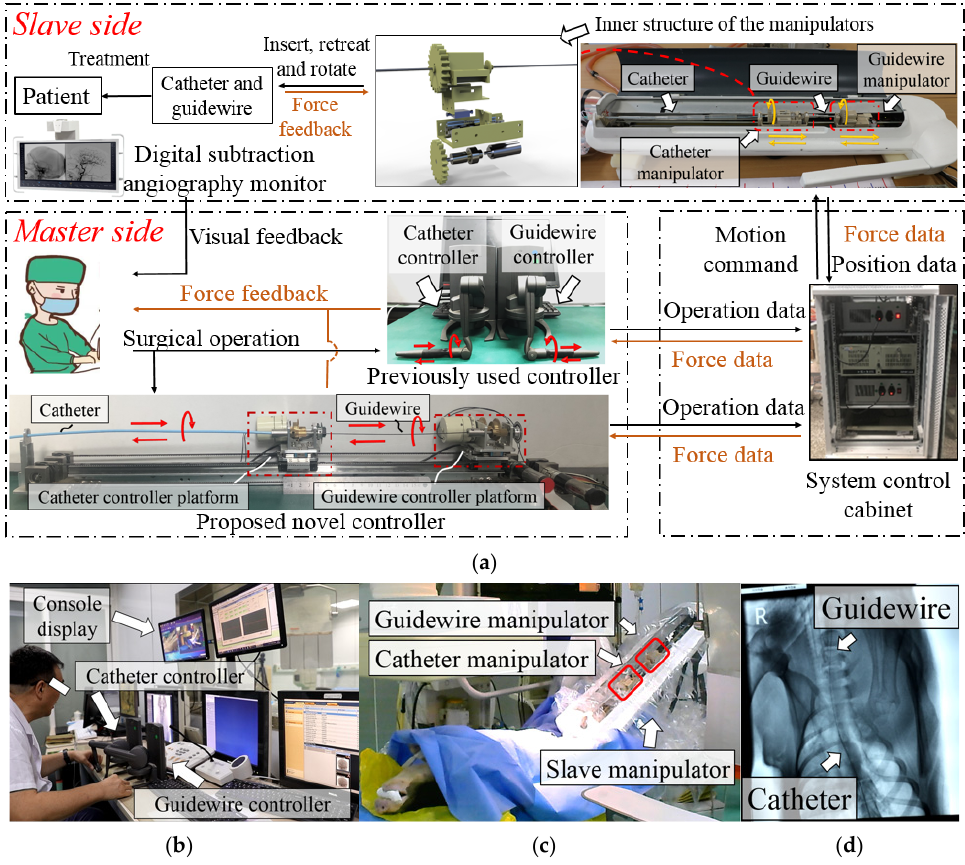
Figure 2. Overview of the developed interventional surgery robot system. ( a ) The concept of master–slave robot-assisted surgery. The surgeon can remotely control the motion of the slave side catheter and guidewire by operating one of the two types of master controllers [15]. ( b ) The operating environment of the master side during previous animal experiments. The surgeon performed intervention operations on an experimental pig outside the operating room. ( c ) The slave side operating environment during previous animal experiments. The slave robot was placed above the operating table, and the catheter and guidewire were inserted into the experimental pig through a puncture. ( d ) Partial angiography results of previous animal experiments [14].